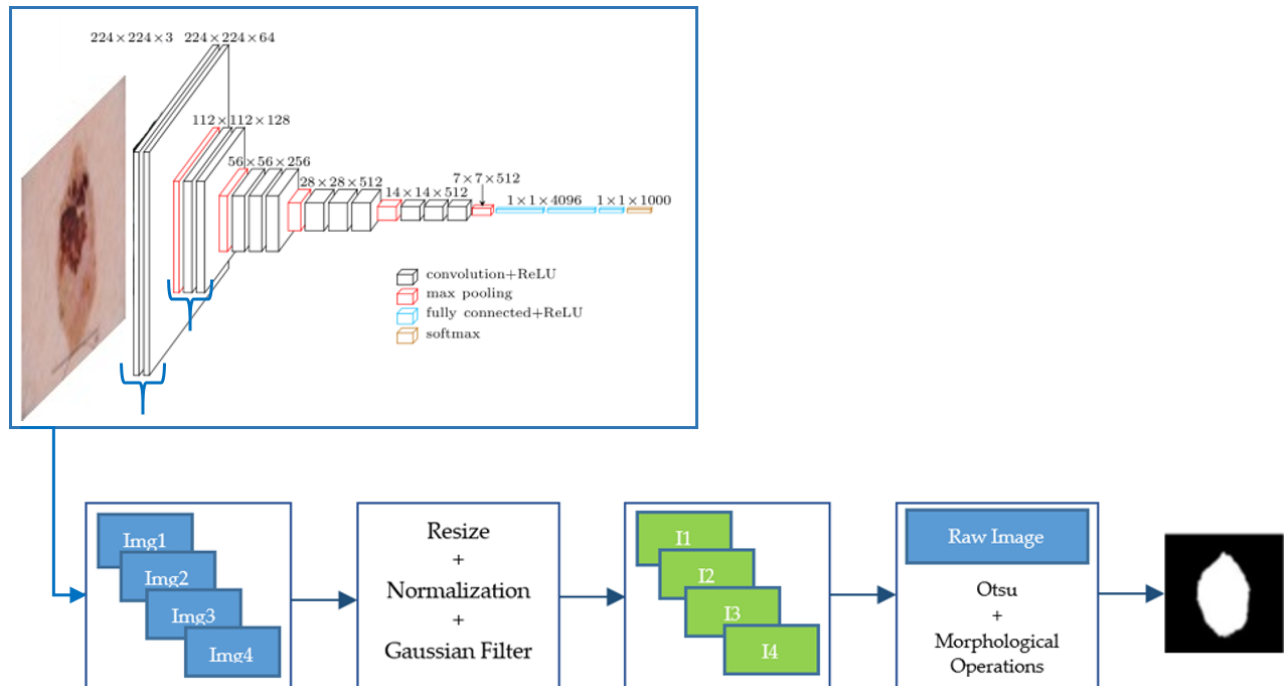
Figure 2. Scheme of this segmentation algorithm from feature images of a CNN.